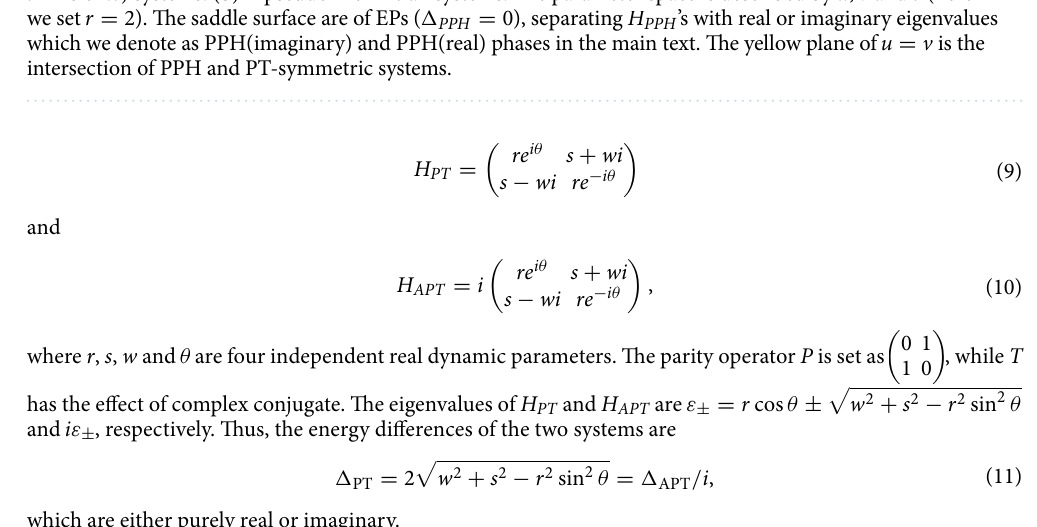
0 1 1 0 (cid:30) , while T (cid:31) w 2 + s 2 − r 2 sin 2 θ (cid:31)